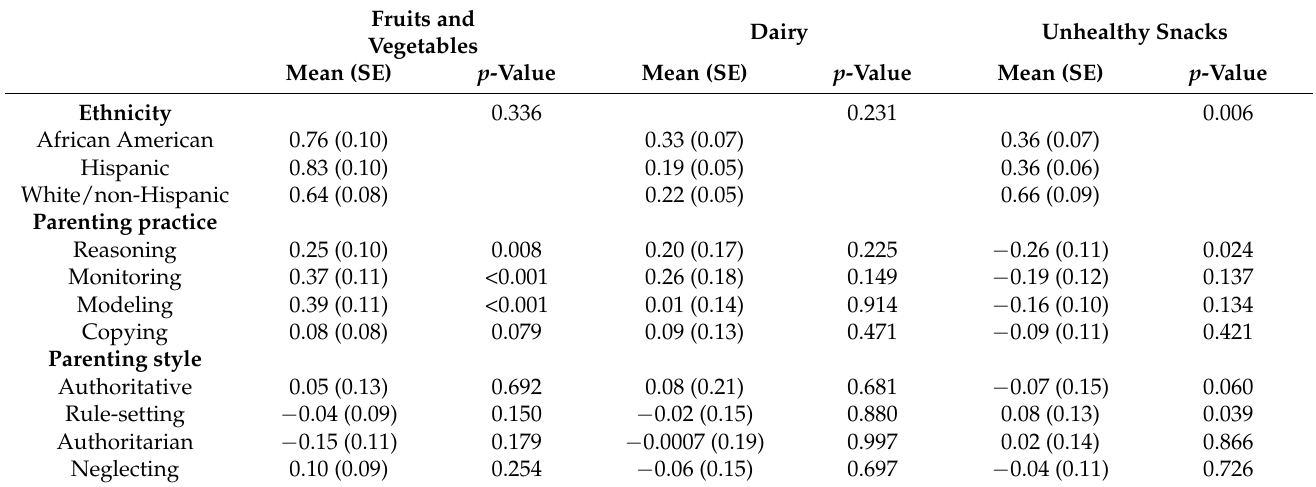
Table 7. Mean number of food items consumed per EO by parenting practice and